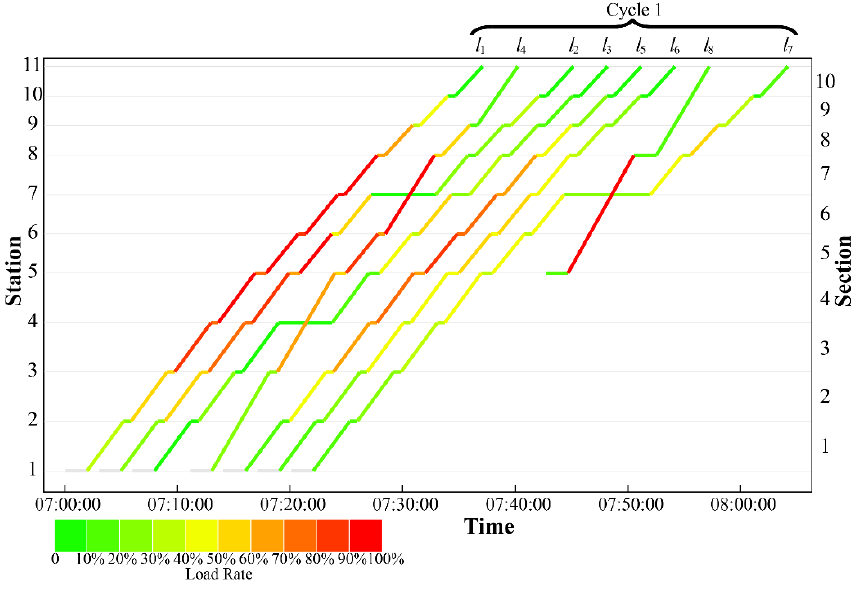
Figure 9. The convergence of solution approach. ( a ) PSL–SUE model. ( b ) MNL–SUE model.